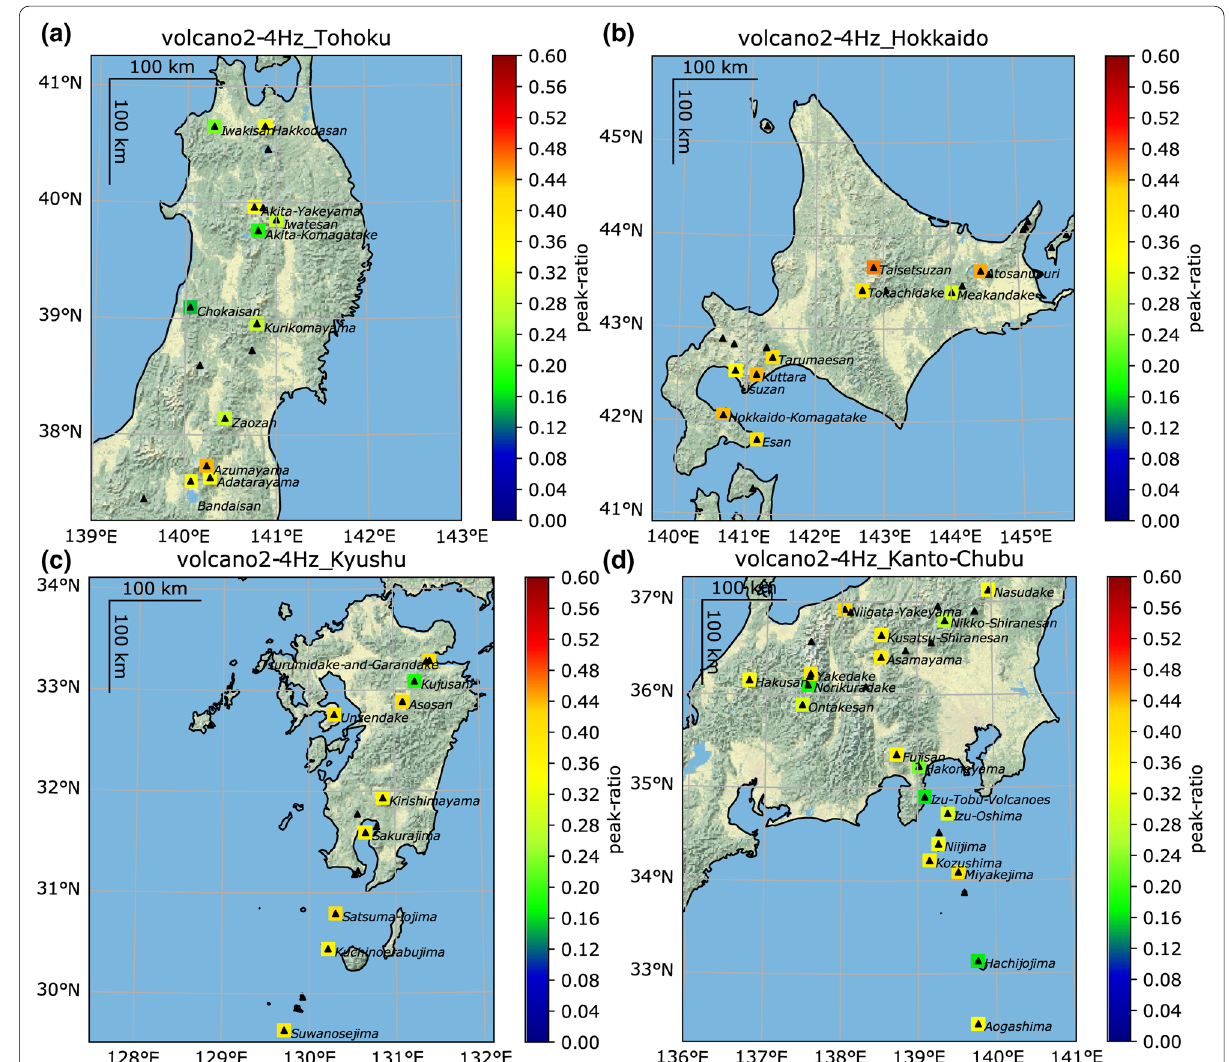
Fig. 2 The distribution of peak amplitude ratio calculated for the JMA volcanic seismometer network averaged for each volcano. Shown are ratios at the 2–4 Hz frequency band for volcanoes across different regions: a Tohoku b Hokkaido c Kyushu d Kanto-Chubu. Hokkaido shows stretches of larger peak ratios whereas Tohoku correspondingly has lower ratios. Kanto-Chubu and Kyushu are somewhere in between, showing a mixture of large and small peak ratios. The colour scheme used mimics the one from Nishimura